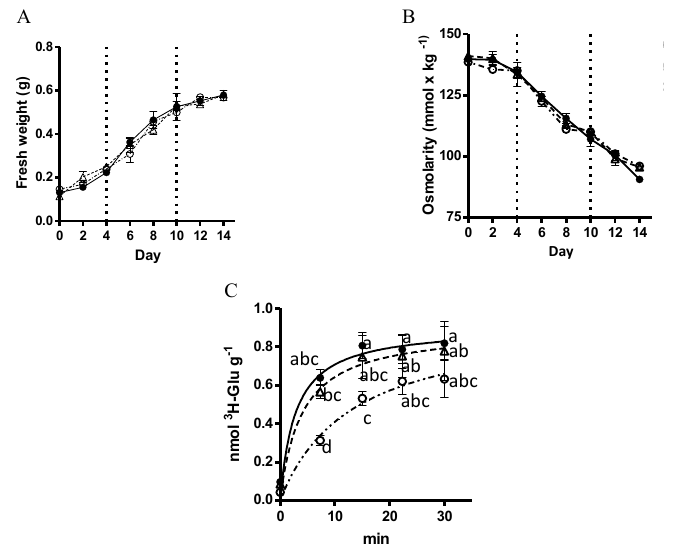
Figure 4. ( A ) Cell growth kinetics of WT, VvMSA-OE and VvMSA-RNAi embryogenic cells (EC). The cell proliferation is expressed as a function of the cell fresh weight. ● -WT; -VvMSA-OE; -VvMSA-RNAi. ( B ) Osmolarity of the culture media of the WT, VvMSA-OE and VvMSA-RNAi cell lines. The dots represent the mean values (±SEM) that were obtained after measurement of 10 µL of medium by using Wescor VAPRO vapor pressure osmometer, model 5520. ( C ) Absorption of D-[ 3 H]-glucose measured in WT, VvMSA-OE and VvMSA-RNAi cells grown at 0.2 mM glucose concentration. The D-[ 3 H]-glucose absorption was reported to the dry weight of the cells. The nonlinear regression curves in ( A – C ) were generated from the mean values (±SEM) of three independent experiments and analysis by ANOVA and Fisher LSD test (p < 0.05 ). No significant differences were found between the groups that were compared either by fresh weight ( A ) or osmolarity ( B ), while the comparison by absorption of D-[ 3 H]-glucose allowed us to discriminate between the groups ( C ). The letters on the dots in ( C ) indicate the level of significant difference between the groups at four time-points of 0, 10, 20 and 30 min.